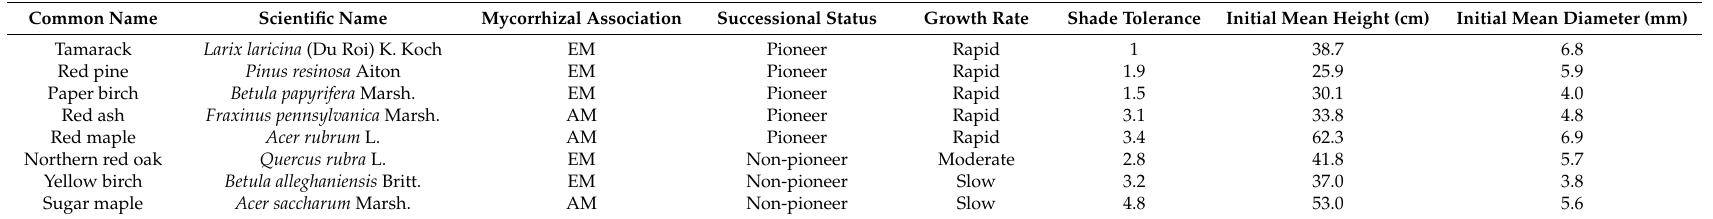
Table 1. Characteristics of the eight tree species planted for this restoration